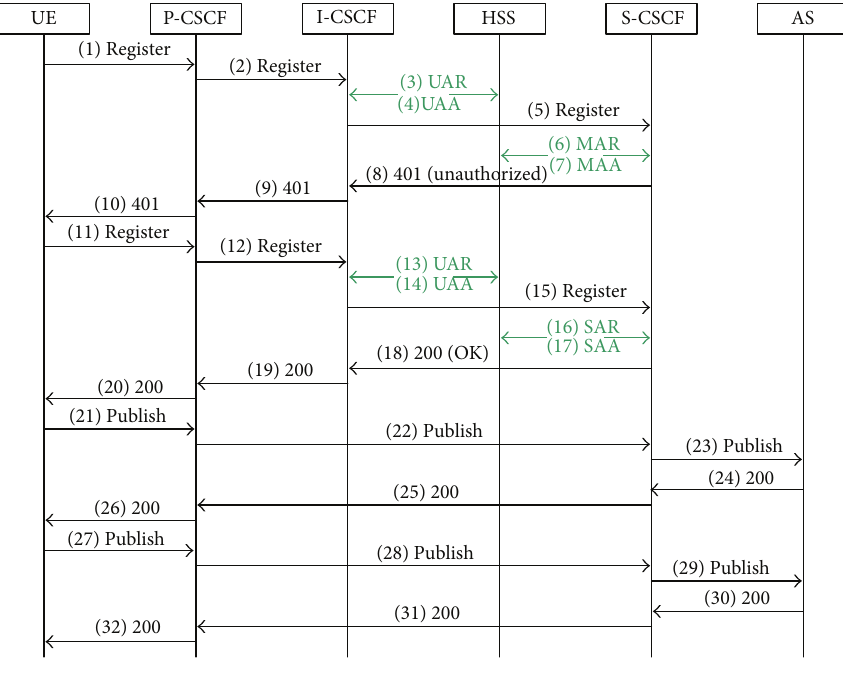
Figure 3: Publication